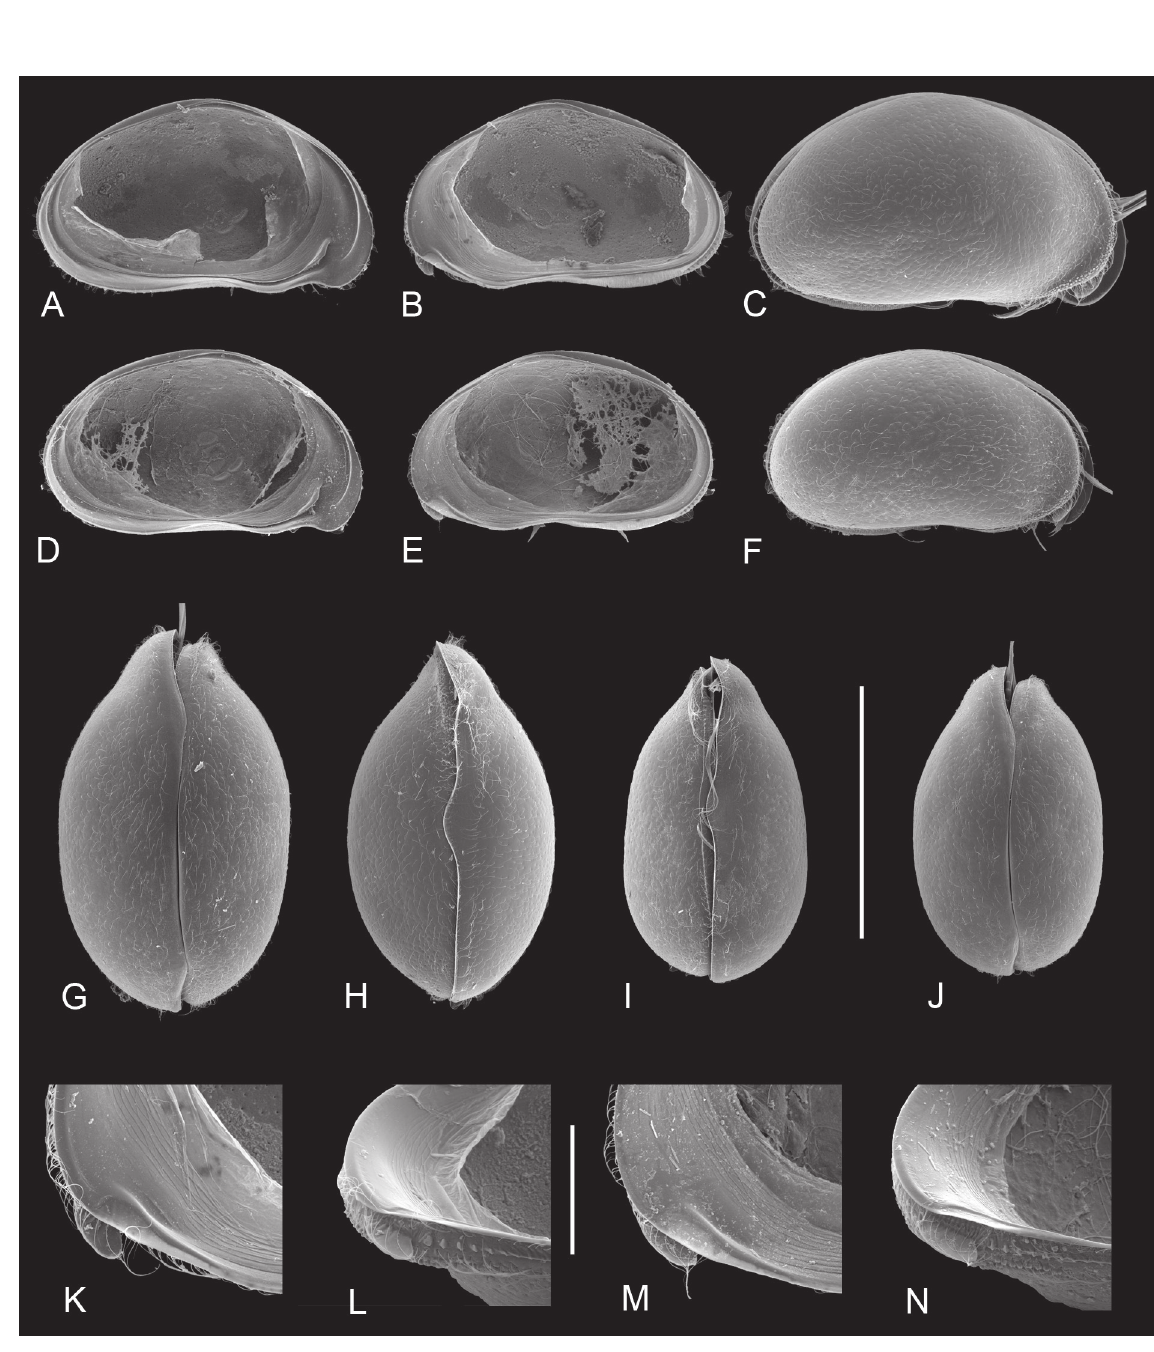
Fig. 18. Bennelongia scanloni sp. nov., type specimens from type locality (One tree Hill creek, DJc/11). A . ♀ allotype, LVi (WAMC52292). B . ♀ allotype, RVi (idem). C . ♀ paratype, CpRL (WAMC52299). D . ♂ paratype, LVi (OC.3329). E . ♂ paratype, RVi (idem). F . ♂ paratype, CpRL (WAMC52295). G . ♀ paratype, cpD (WaMc52297). H . ♀ paratype, CpV (WAMC52298). I . ♂ paratype, CpV (WAMC52295). J . ♂ paratype, CpD (WAMC52296). K . ♀ allotype, RVi, detail anterior (WAMC52292). L . ♀ allotype, rVi, detail anterior, tilted (idem). M . ♂ paratype, RVi, detail anterior (OC.3329). N . ♂ paratype, RVi, detail anterior, tilted (idem). scales: a-J = 1 mm; K-n = 200